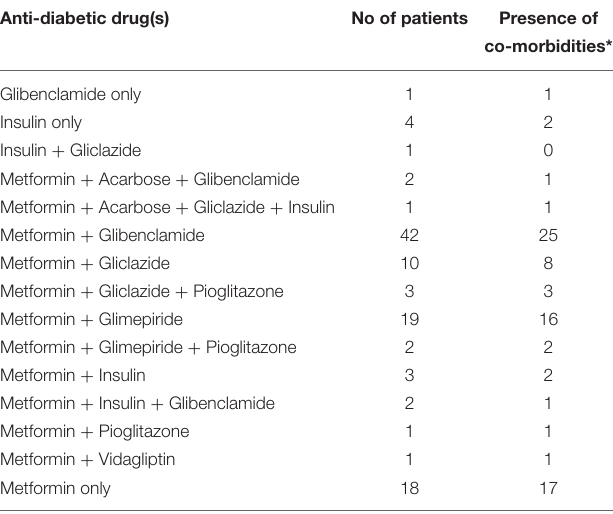
TABLE 2 | Tabular summary of the pharmacological management of the patients’ based on their prescribed hypoglycaemic agents. Anti-diabetic drug(s) No of patients Presence of